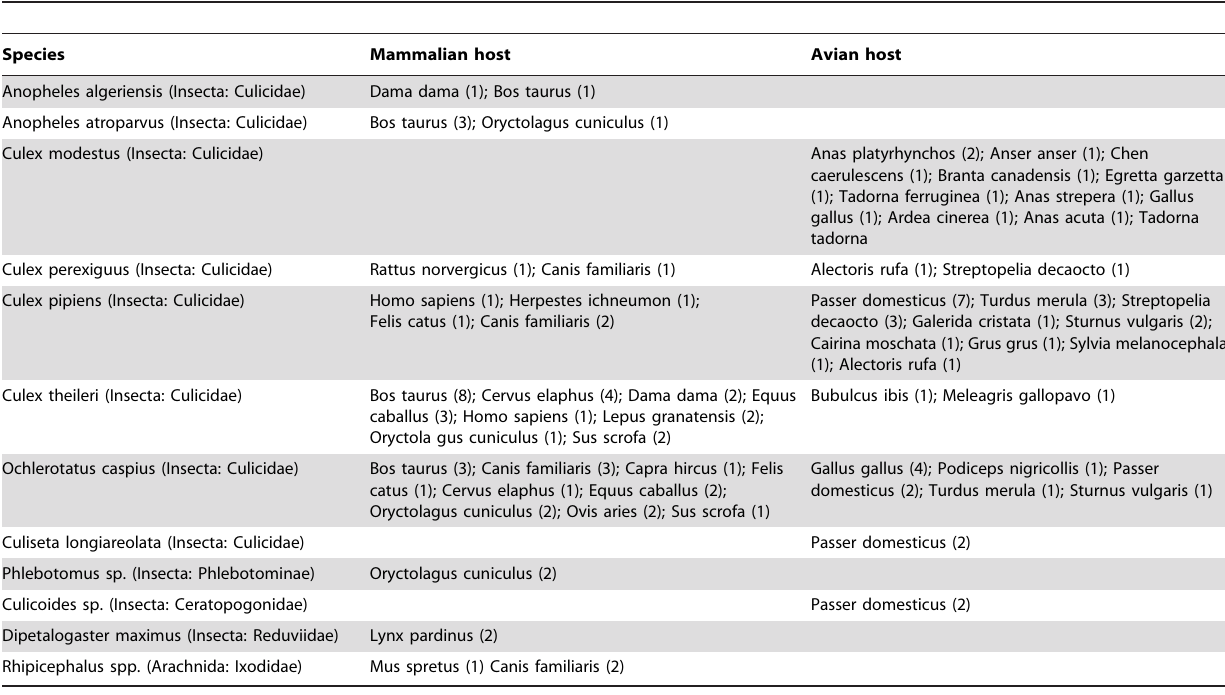
Table 1. Vertebrate hosts for different species of blood-feeding ectoparasites collected in South-western Spain.